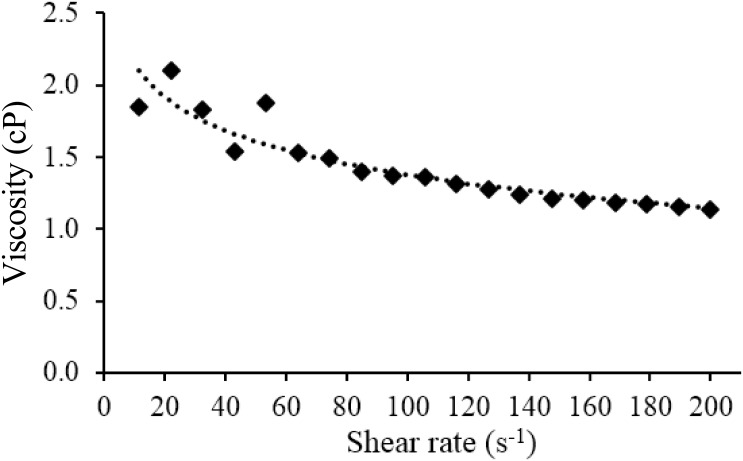
The viscosity of 2.5% w/v suspension of 153Sm-Amberlite in saline at 37°C with various shear rate.